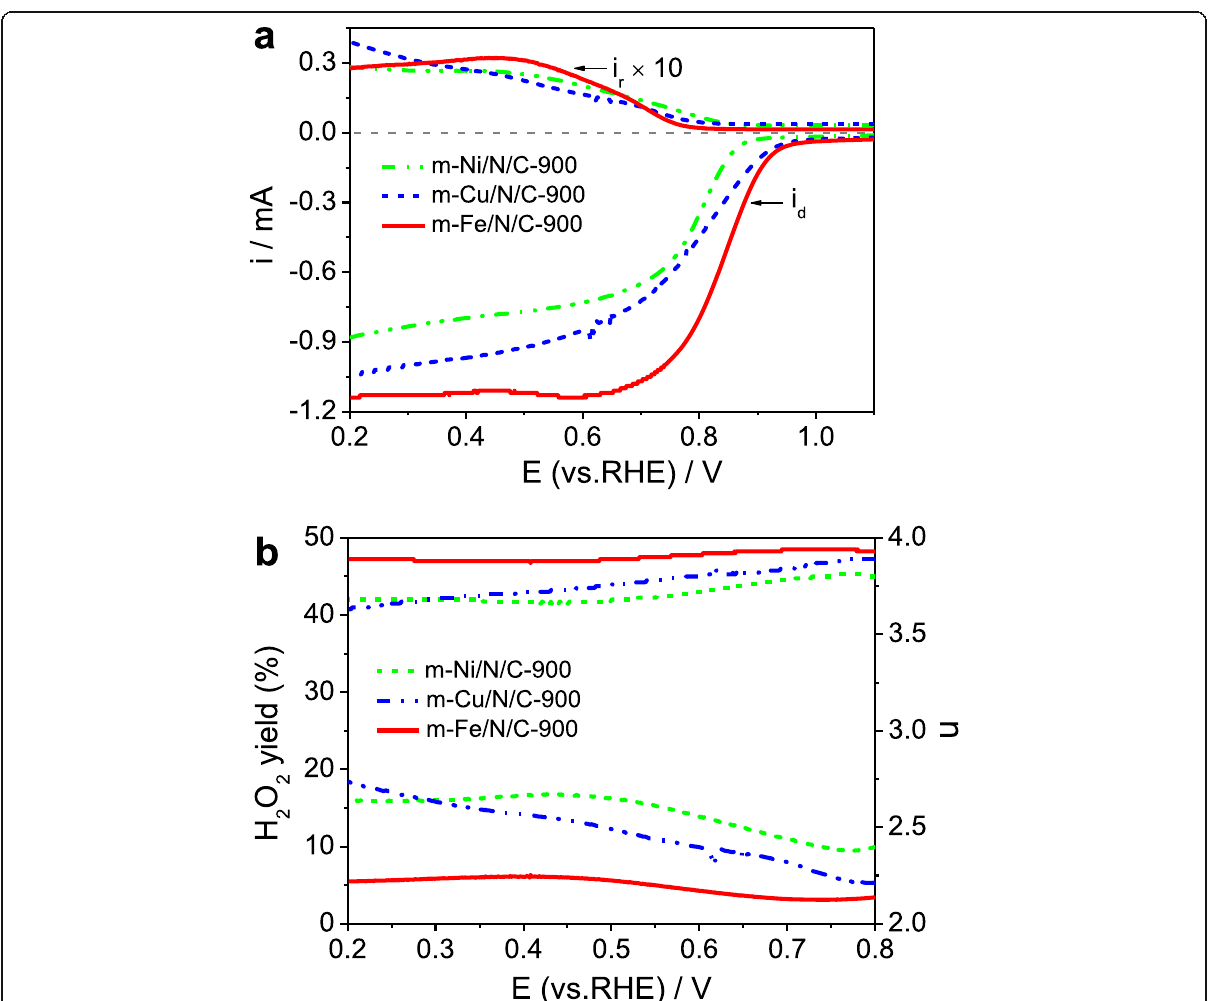
Fig. 9 a Disk and ring currents obtained with LSVs on RRDE for m -Ni/N/C-900, m -Cu/N/C-900, and m -Fe/N/C-900 in O 2 -saturated 0.1 mol l -1 KOH solution. b The corresponding electron transfer number and H 2 O 2 yield of m -Ni/N/C-900, m -Cu/N/C-900, and m -Fe/N/C-900 derived from a . c CV curves and d LSV curves of m -Fe/N/C-900 before and after continuous scanning for 5000 cycles in O 2 -saturated 0.1 M KOH